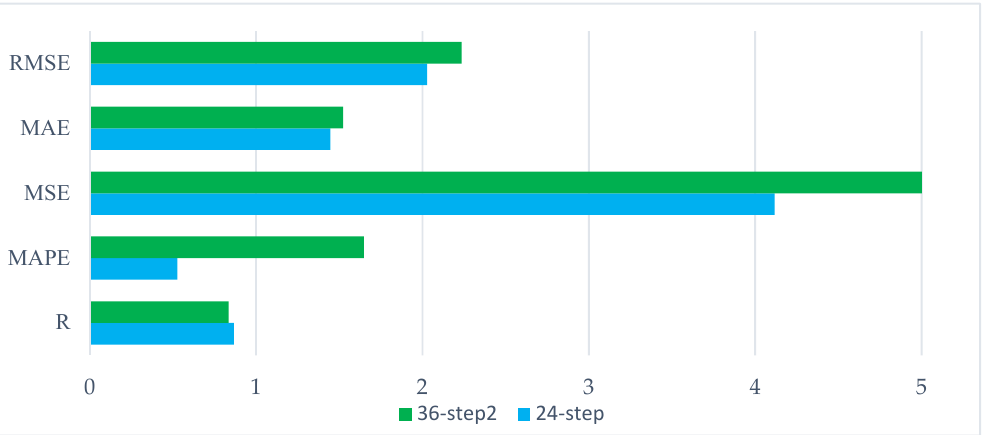
Figure 12. Comparison of prediction results with different step sizes in multivariable input.